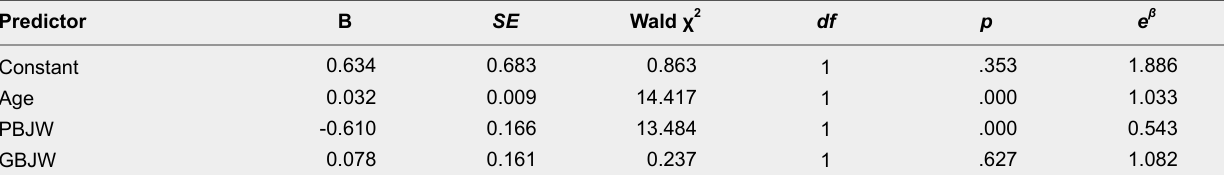
Logistic Analysis Results Predicting Bribe-Giving Behavior (n =